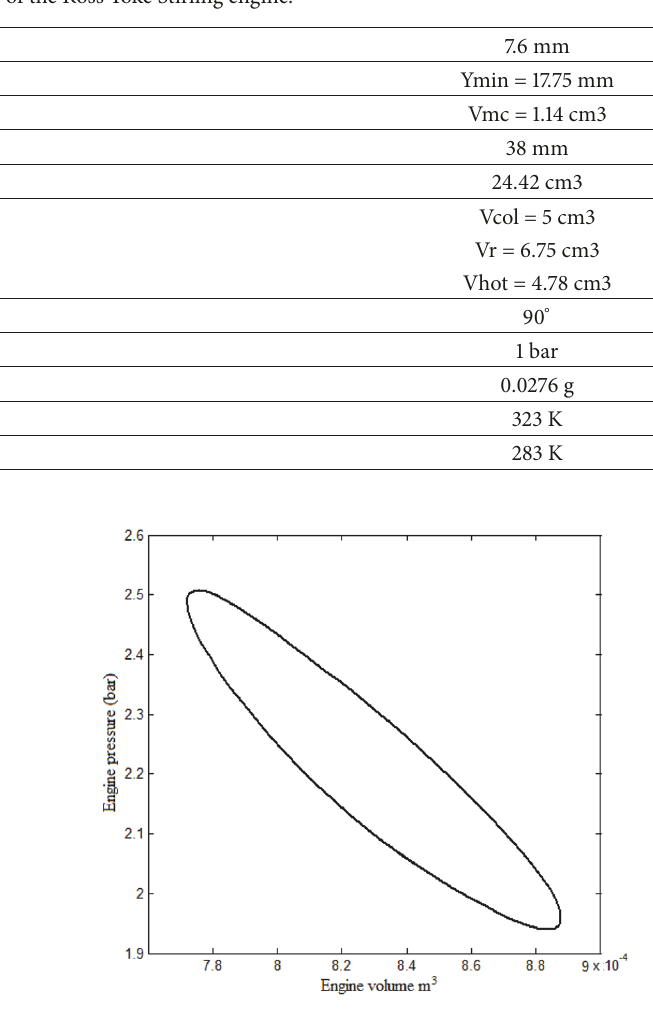
Figure 10: Pressure volume